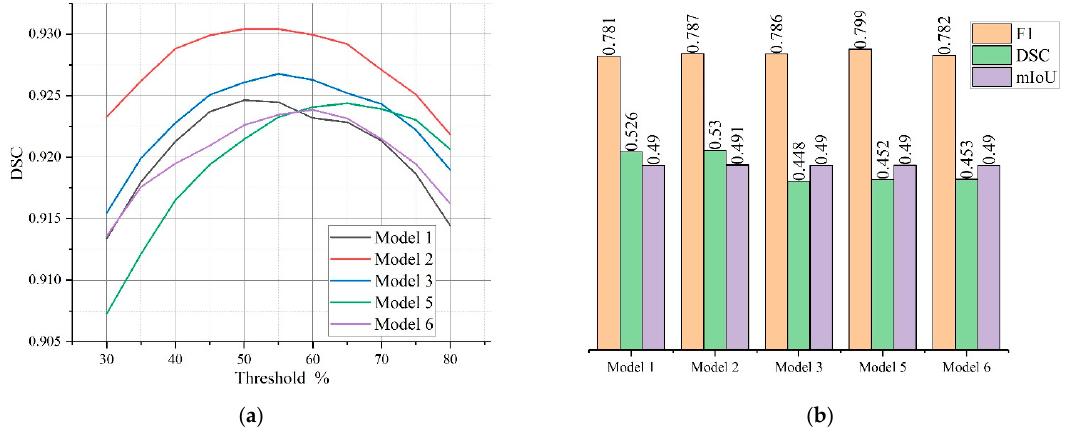
Figure 5. Dependence of the test metric 𝐷𝑆𝐶 on threshold values of the output layer ( a ) and values of the validation metrics 𝐷𝑆𝐶 , 𝑚𝐼𝑜𝑈 and 𝐹1 for different models ( b ).